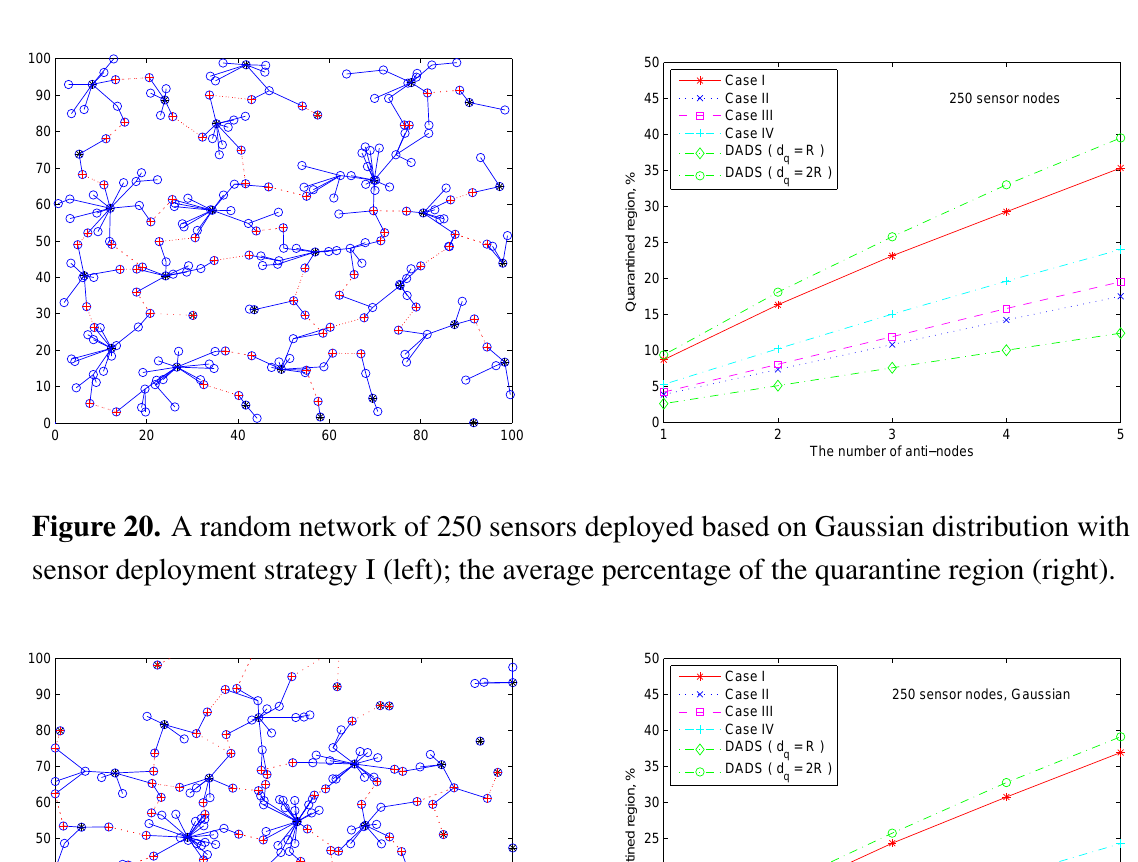
Figure 19. A random network of 250 sensors deployed based on uniform distribution (left); the average percentage of quarantine region with R = 9.4 (right).